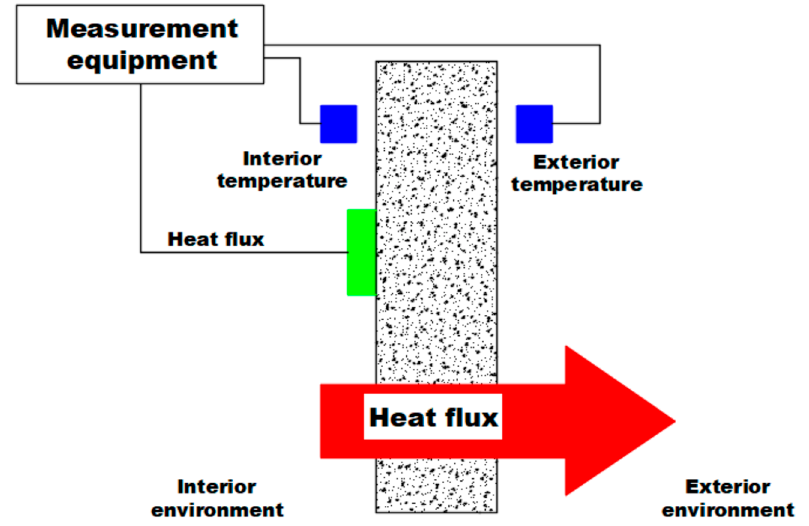
Figure 2. Measurement scheme.